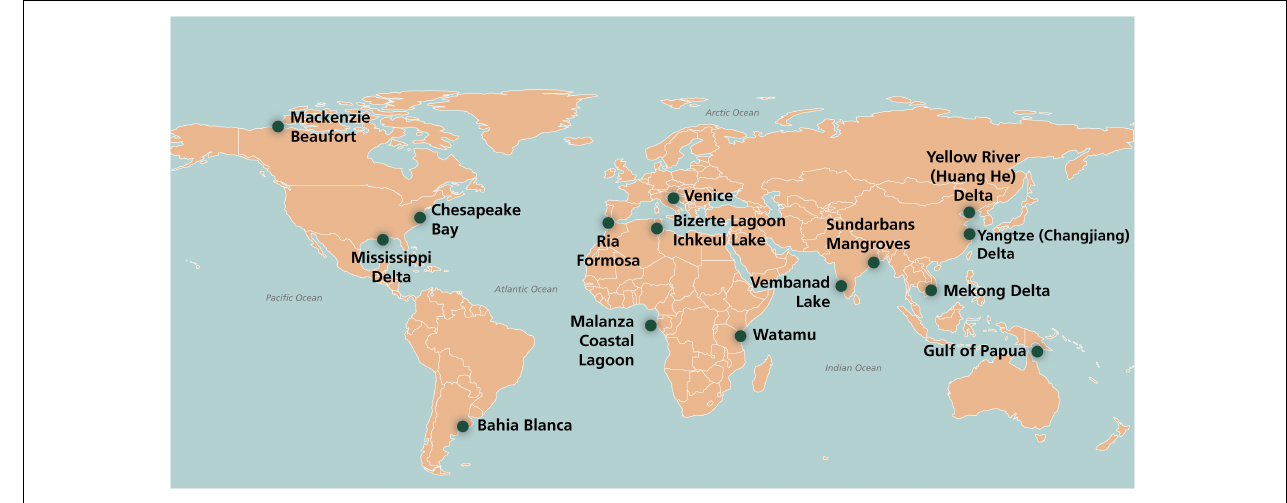
FIGURE 1 | Map showing location of the coastal wetlands in the text. (Credit: Dylan